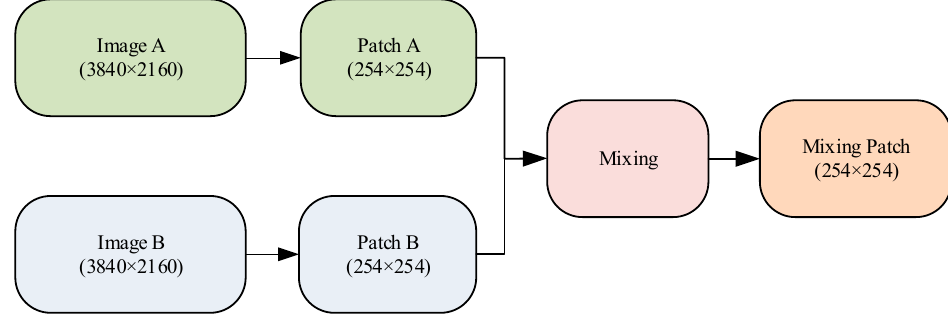
Figure 2. Image sample augmentation process based on